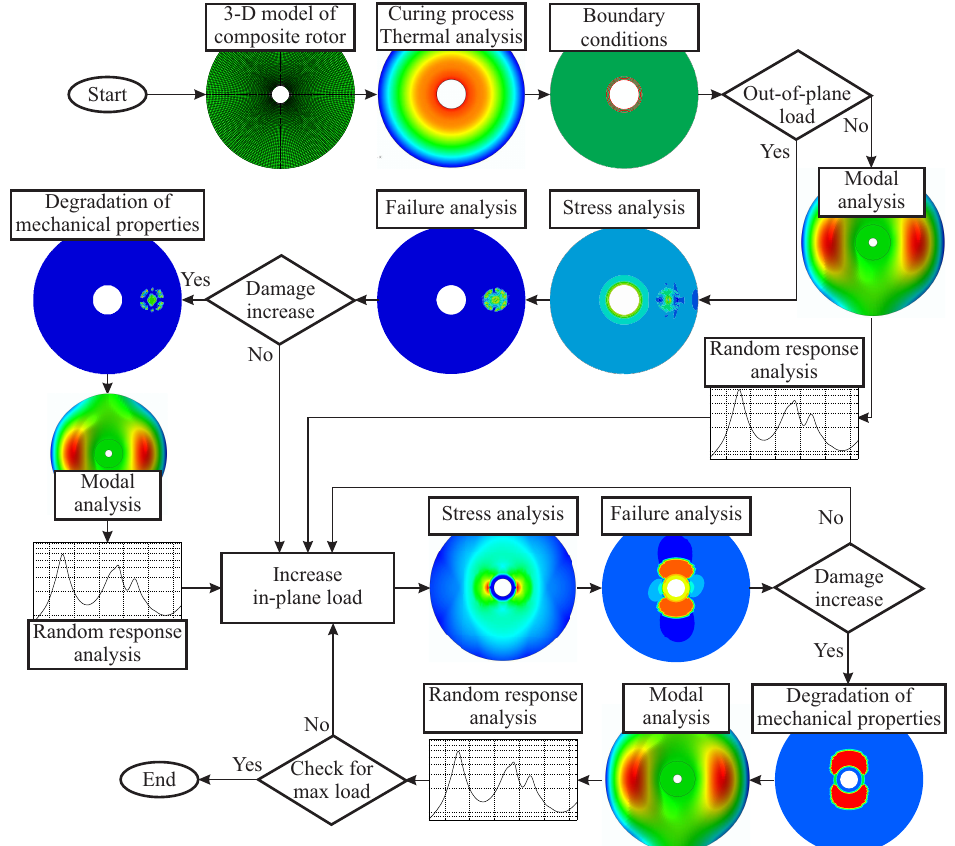
Figure 7. Flowchart for the progressive failure damage analysis for a composite rotor under out-of-plane and in-plane loading.